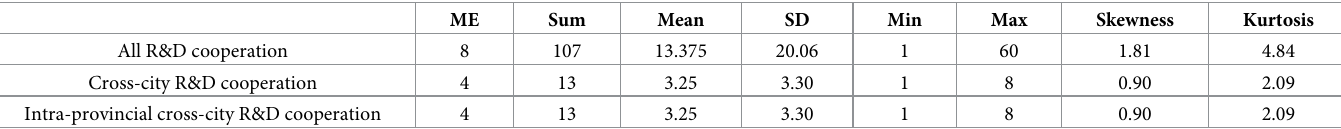
Table 8. Descriptive statistics of the Pearl River Delta 2008–2010.